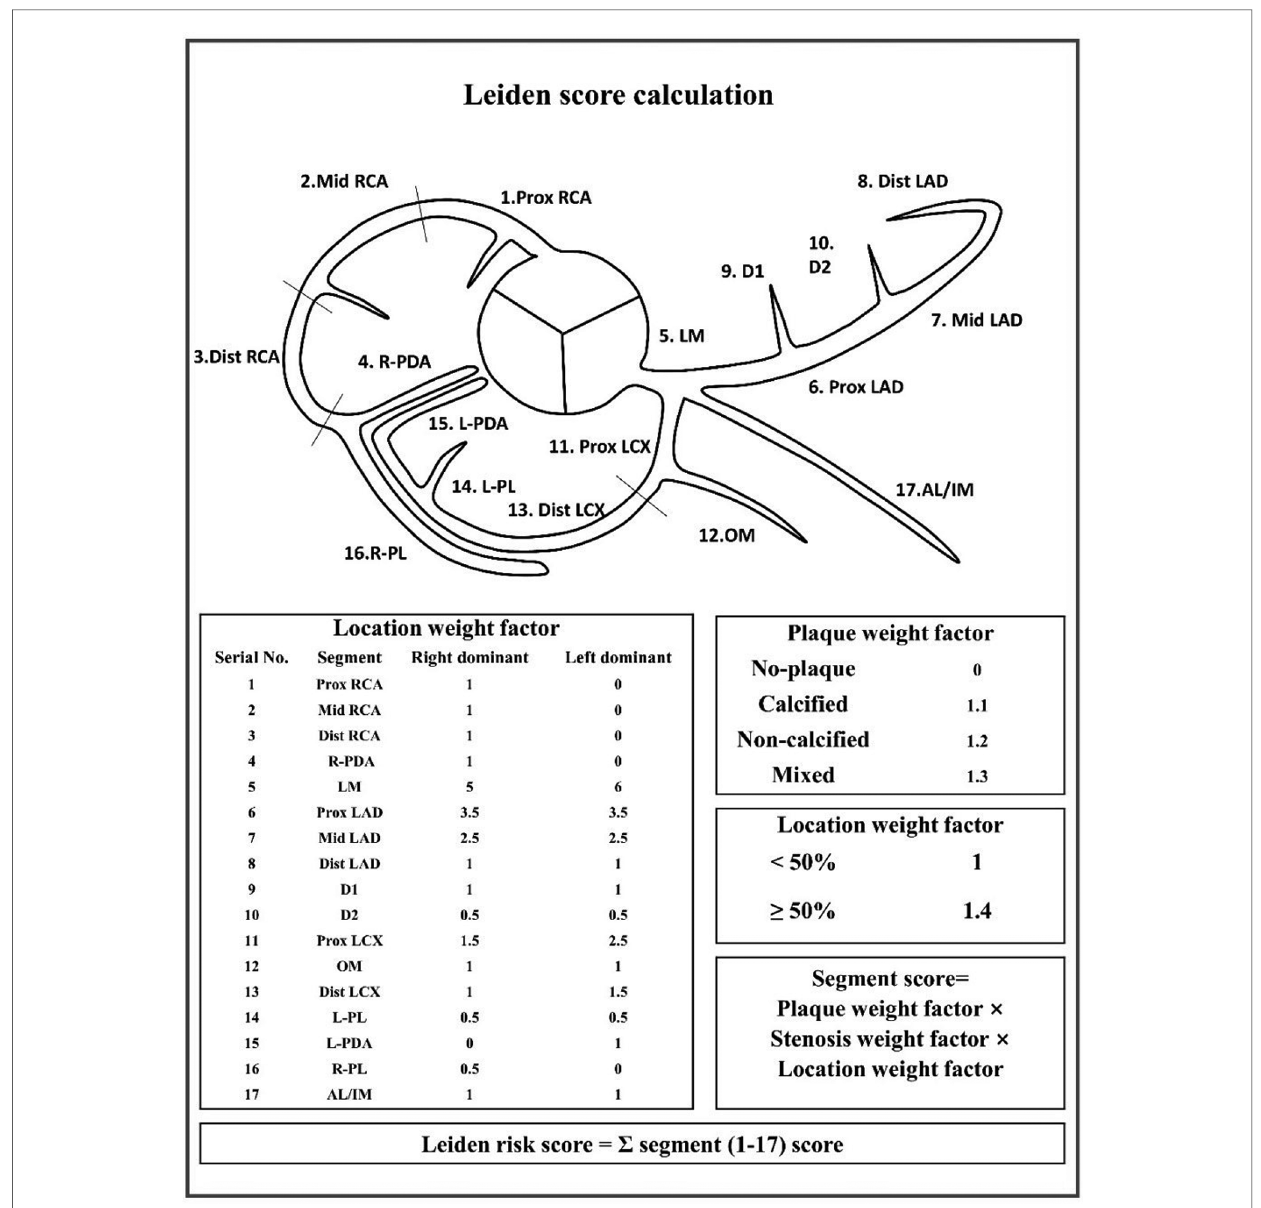
FIGURE 2 The speci fi c scoring method of Leiden